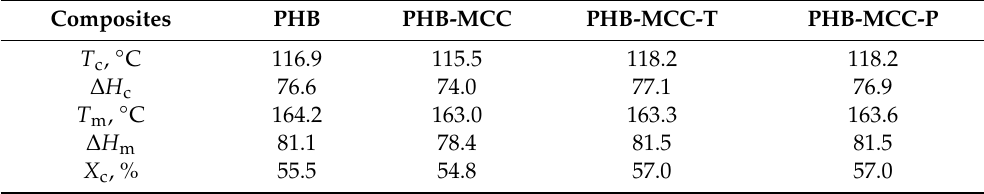
Figure 8. DSC thermograms of PHB and composites for the first ( a ) and second heating ( b ). Figure 8. thermograms of PHB and composites for the first ( a ) and second heating ( b ) . Table 4. DSC data collected from the heating-cooling-heating DSC curves of Table 4. DSC data collected from the heating ‐ cooling ‐ heating DSC curves of composites.